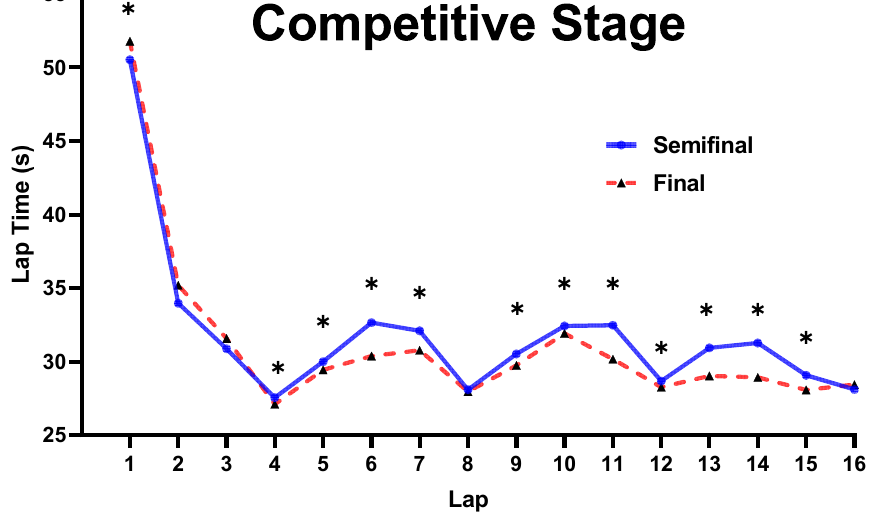
Figure 3. Comparison of lap time spent for CS. Note: * marked values were significant when p ≤ 0.05. Furthermore, there was a main effect for SL on laps 4, 8, 9, 12, 13, 15, and 16 ( p ≤ 0.014) (Figure 4): (i) The speed on laps 4, 8, 12, and 15 was significantly faster in the top level than the middle and low levels ( p = 0.006); (ii) the speed on lap 9 was significantly faster in the top and low levels than the middle level ( p = 0.024), while there were no significant differences between the top and low levels ( p = 0.923); (iii) the speed on lap 13 was significantly faster in the low level than the middle level ( p = 0.004), while there were no significant differences among the top, middle, and low levels ( p = 0.123); and (iv) the speed on lap 16 was significantly faster in the top level than the middle and low levels ( p ≤ 0.001), and the middle level was significantly faster than the low level ( p = 0.006).